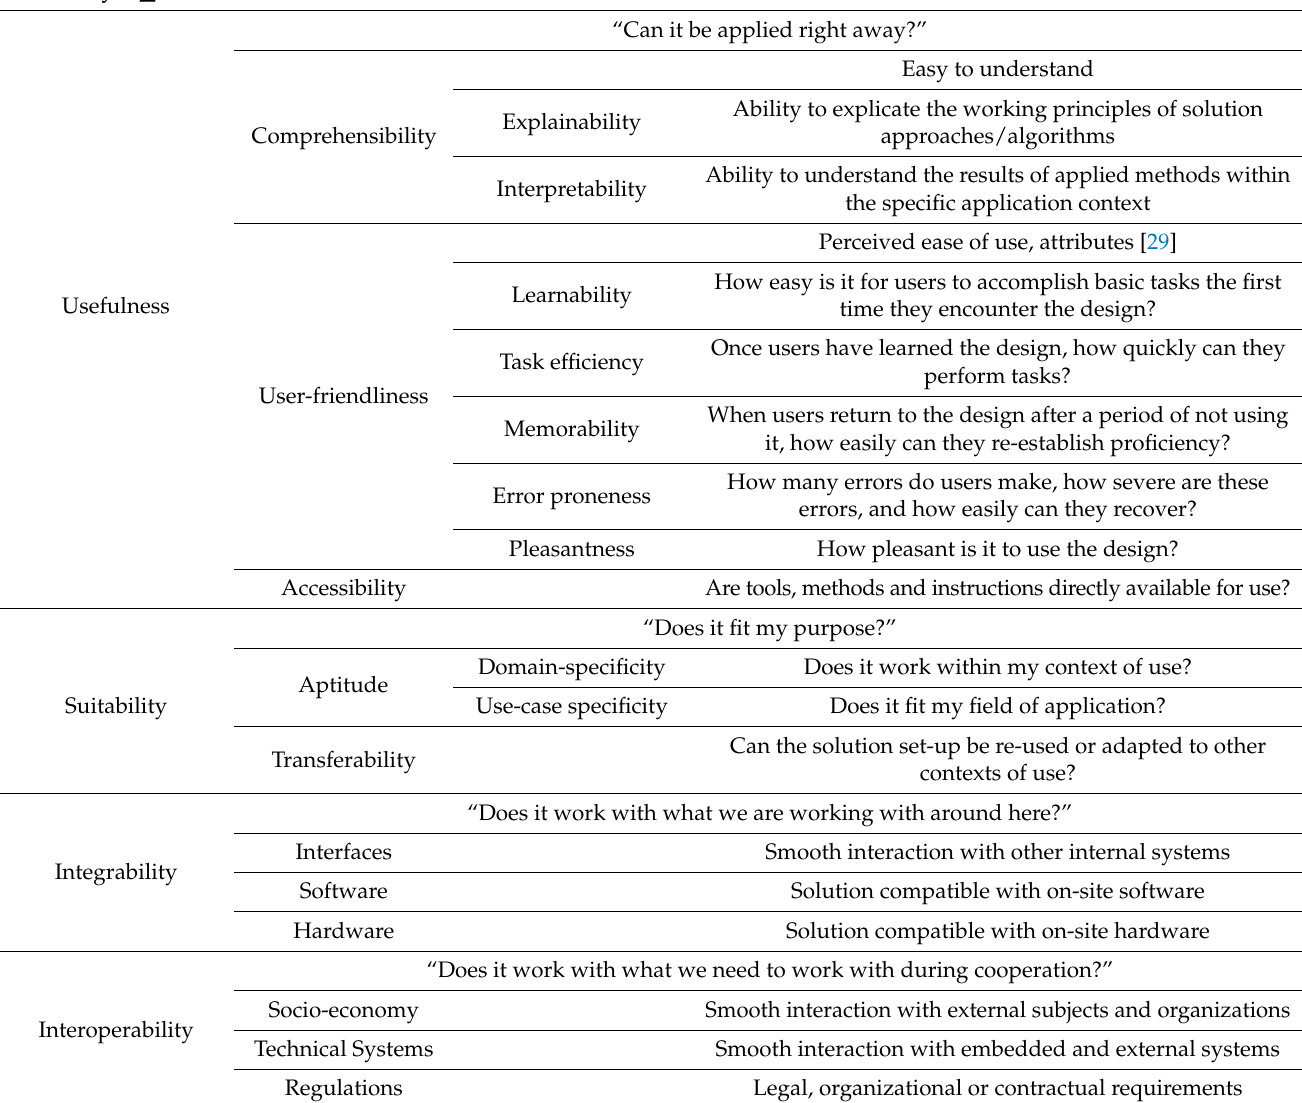
Table 4. Description of attributes of the UAI